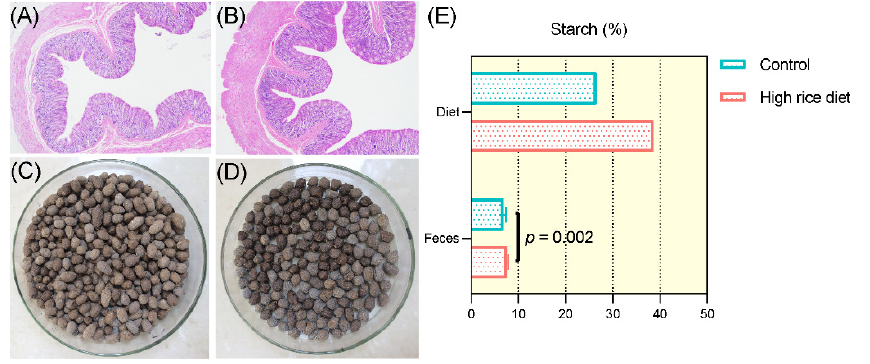
Figure 9. Intestinal morphology and fecal observation of goats. Light microscopy cross-section of the colon tissue from a representative control diet-fed goat ( A ) or HR diet-fed goat ( B ). Fecal photos of goats fed a control diet ( C ) or HR diet ( D ). ( E ) Starch content in goats after applying the two diets and in the feces after being fed the control diet or HR diet.